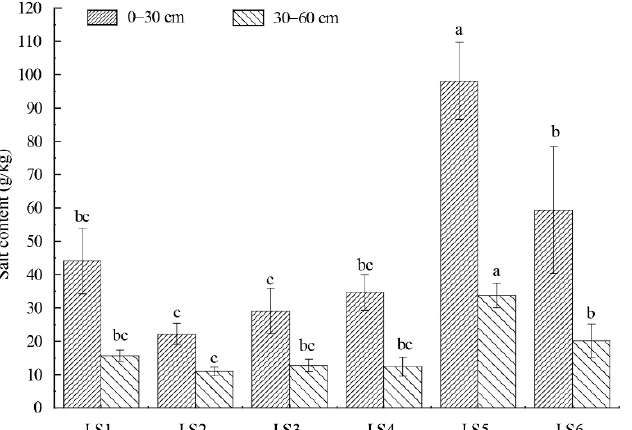
Figure 8. Salt content of the sediments collected from the different landscapes (different letters indicate significant differences between parameters ( p < 0.05)). Table 3. Correlation analysis between grain size parameters and salt content of sediments from different landscapes.